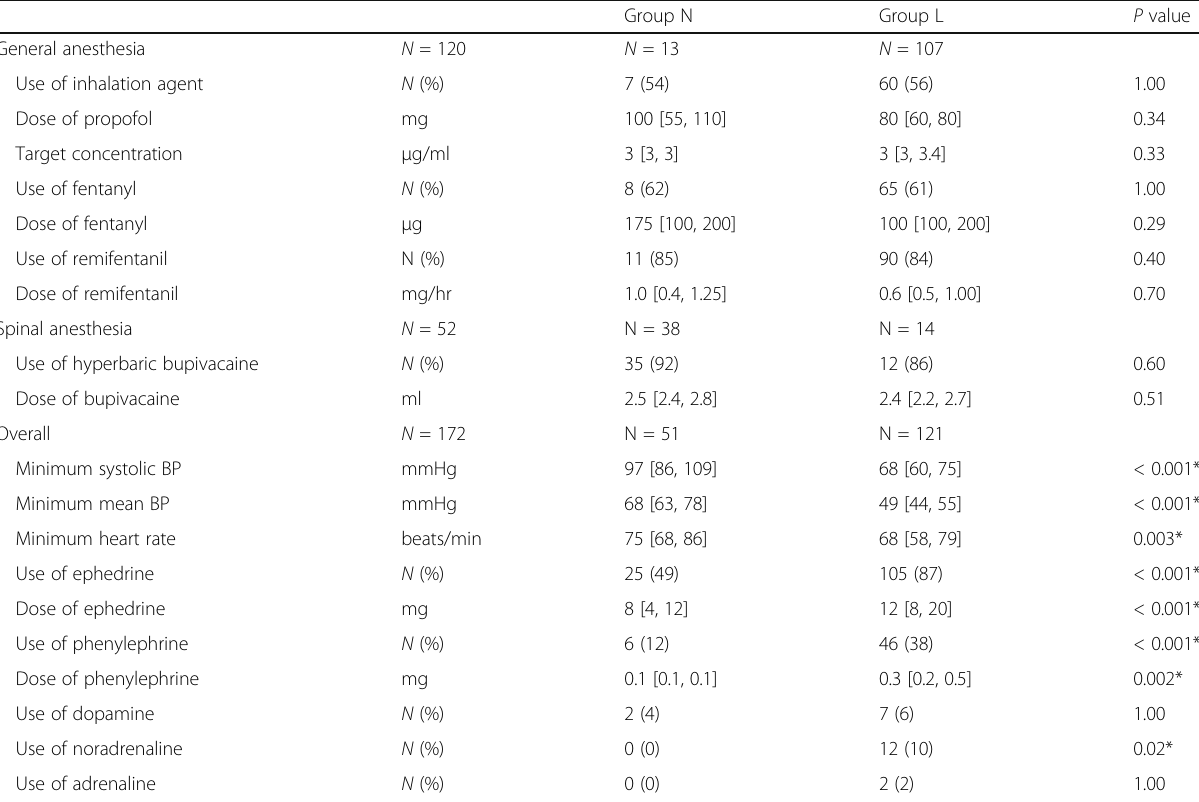
Table 2 Detail of anesthesia procedure and treatment for hypotension